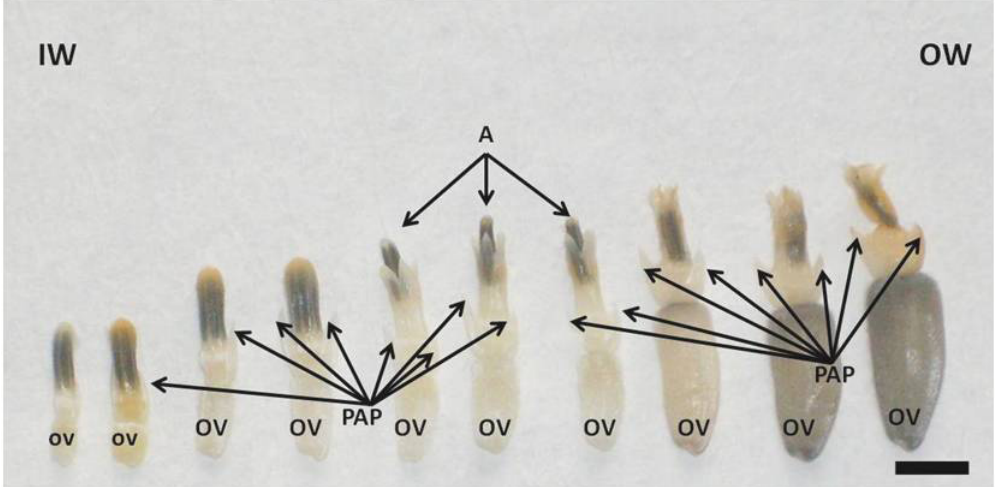
Fig. 6. Hermaphrodite florets which are in different stages of development on a mature capitulum in H. an- nuus . A: Anther; IW: Inner whorl florets; OV: Ovary; OW: Outer whorl florets; PAP: Pappus. Bar: